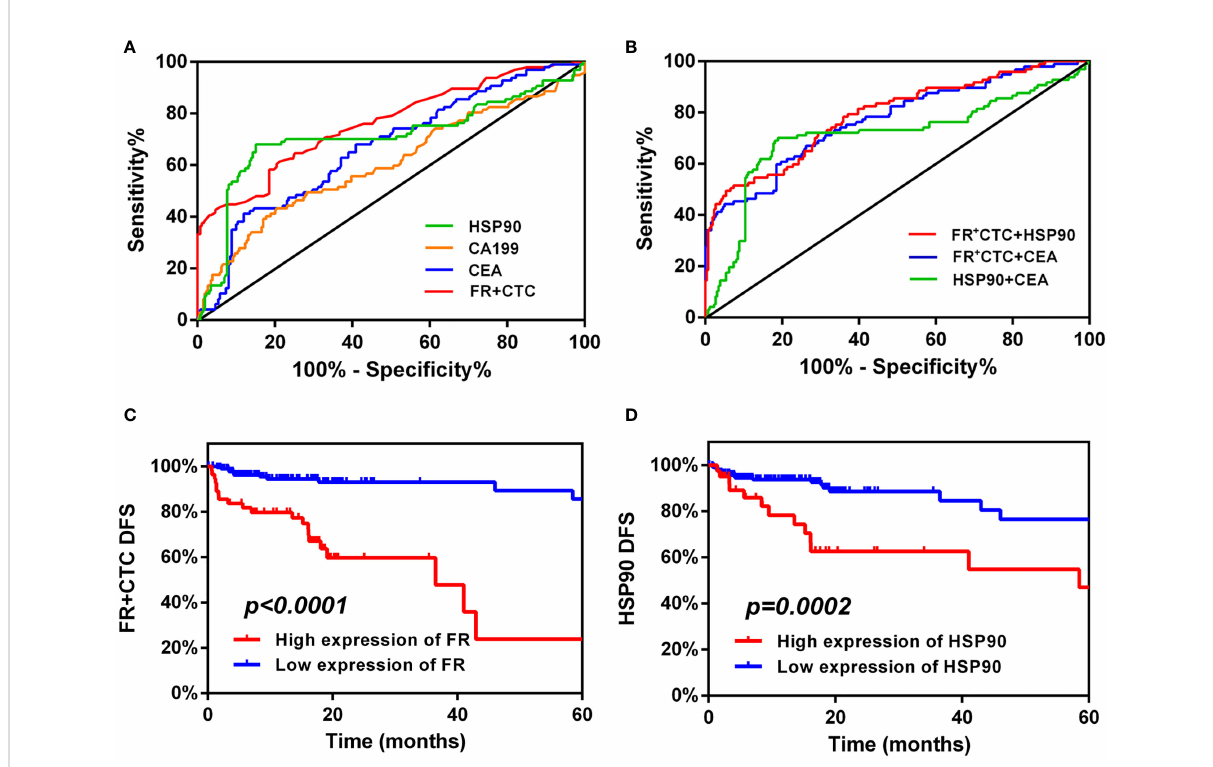
FIGURE 3 Diagnostic and prognostic capabilities offolate receptor plus circulating tumor cells (FR+CTC) and heat shock protein 90 (HSP90). (A) Receiver operating characteristic (ROC) curve analysis: the diagnostic ability of single FR+CTC, HSP90, CEA, and CA199 in differentiating liver metastatic colorectal cancer. (B) ROC curve analysis: the diagnostic ability of combined markers in differentiating liver metastatic colorectal cancer were FR+CTC and HSP90, FR+CTC and CEA, and HSP90 and CEA, respectively. High expression of FR+CTC (C) and HSP90 (D) predicts the median disease-free survival (mDFS) of liver metastatic colorectal cancer.